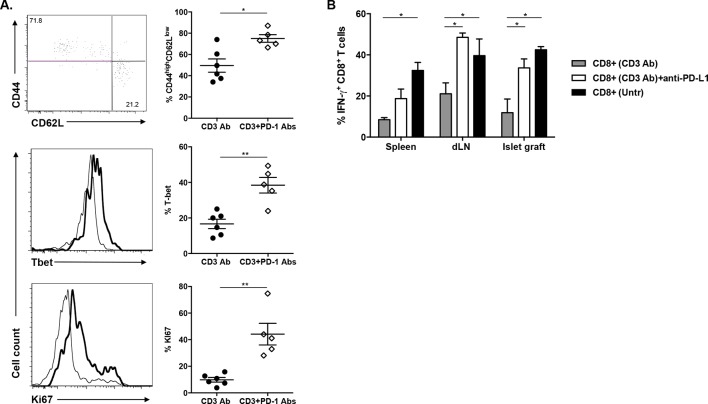
Administration of anti-PD-1 or anti-PD-L1 Abs reversed CD3 Ab-induced unresponsiveness of CD8+ T cells.